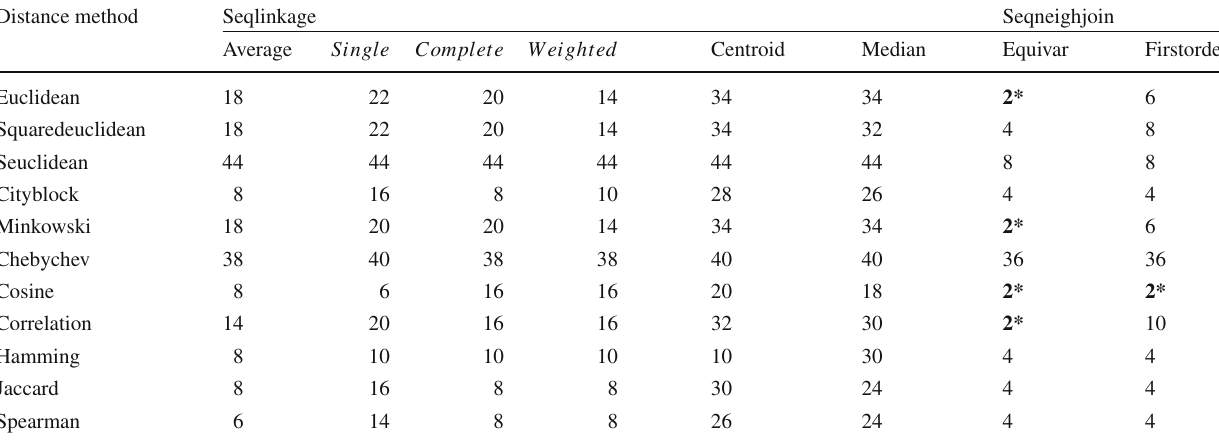
Table 4 RF distances for different distance method and phylogenetic tree generation method for Fish dataset in Table 1 using k = 8 and S r = 4 Distance